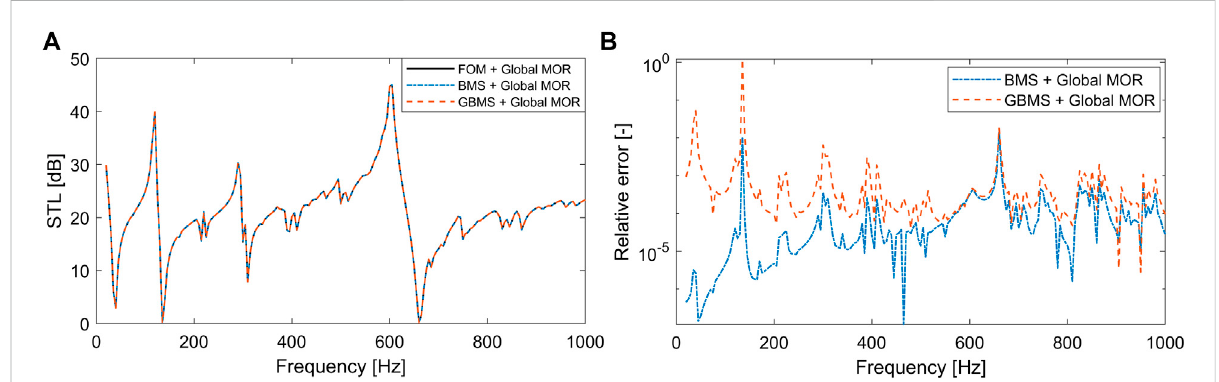
FIGURE 9 STL results (A) and relative error with respect to the FOM + global MOR (B) computed for the clamped fi nite plate assembly of 15 × 15 UCs for different ROMs. The good agreement between the results causes the STL curves (A) to appear on top of each other.